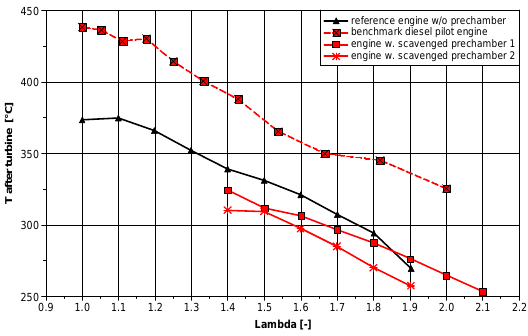
Fig. 22. Temperature after turbine for the operating point 1 (1400 rpm/50